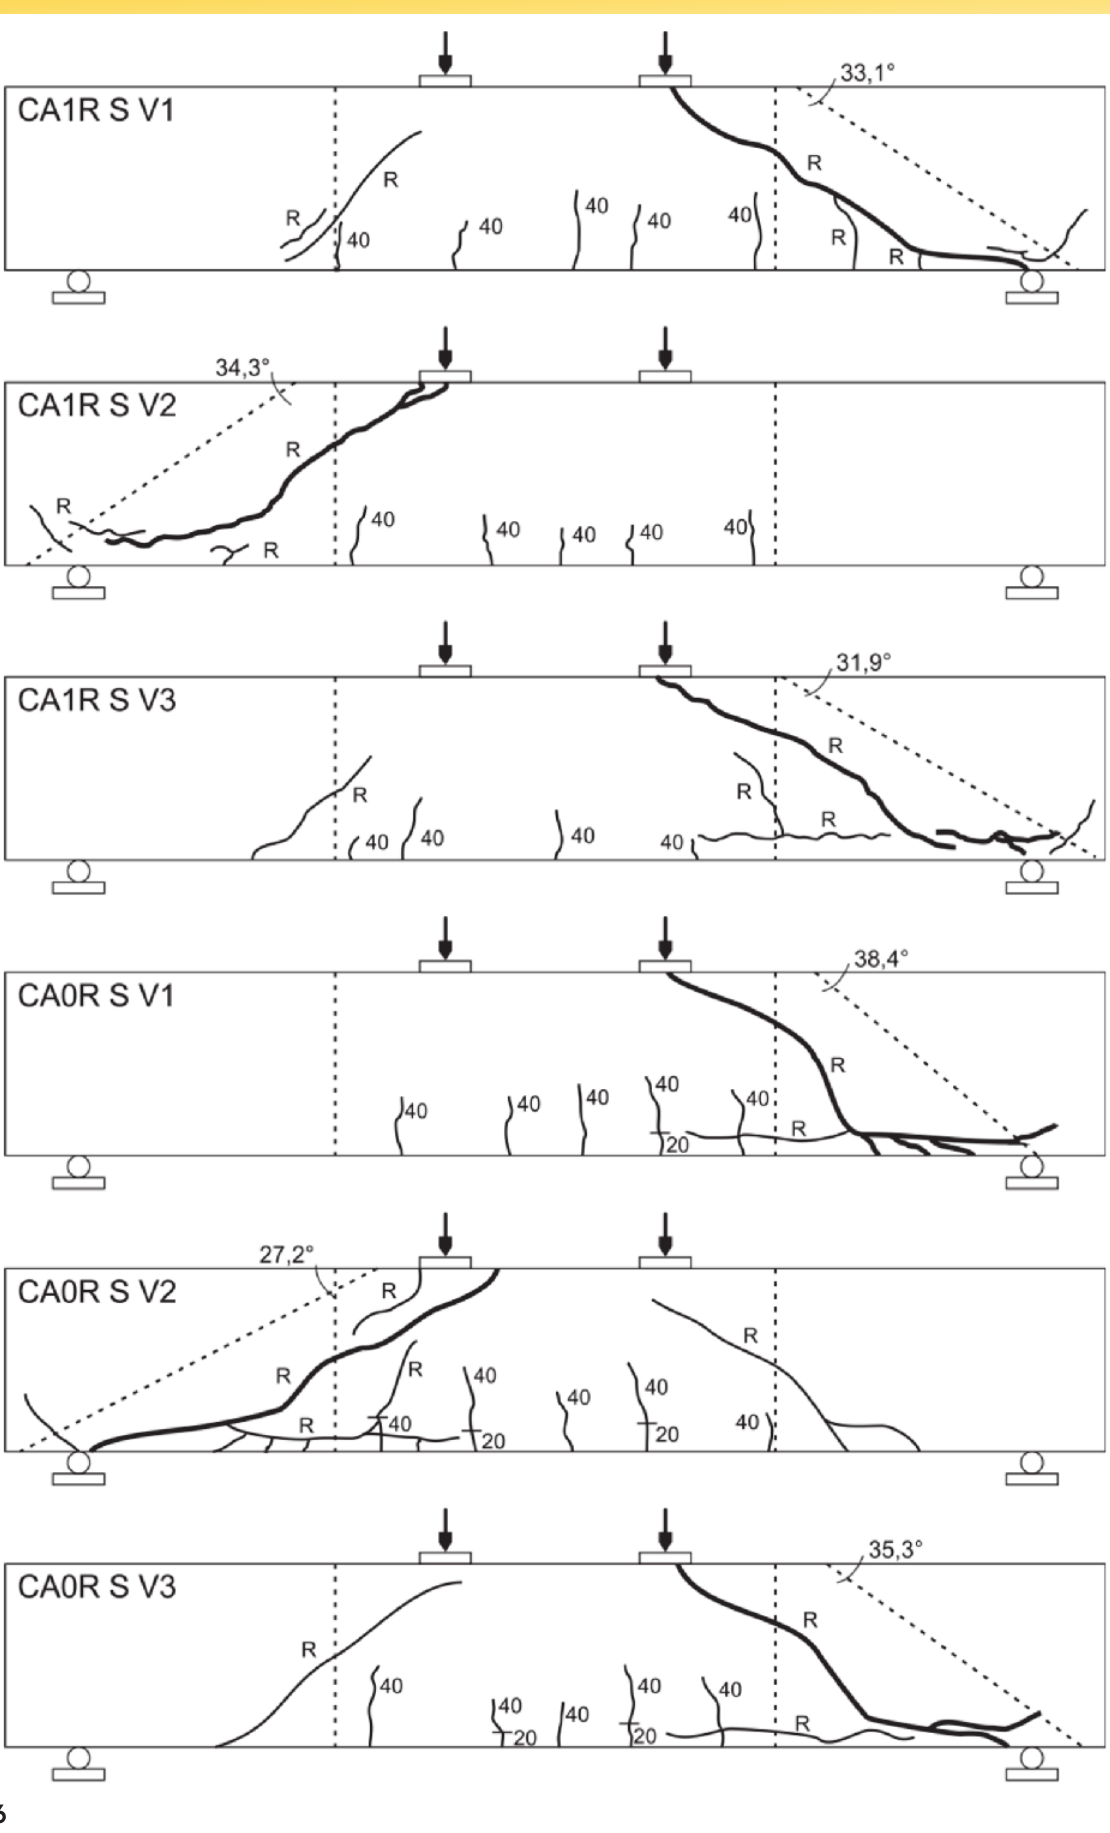
Crack patterns of self-consolidating concrete beams with reduced amount of coarse